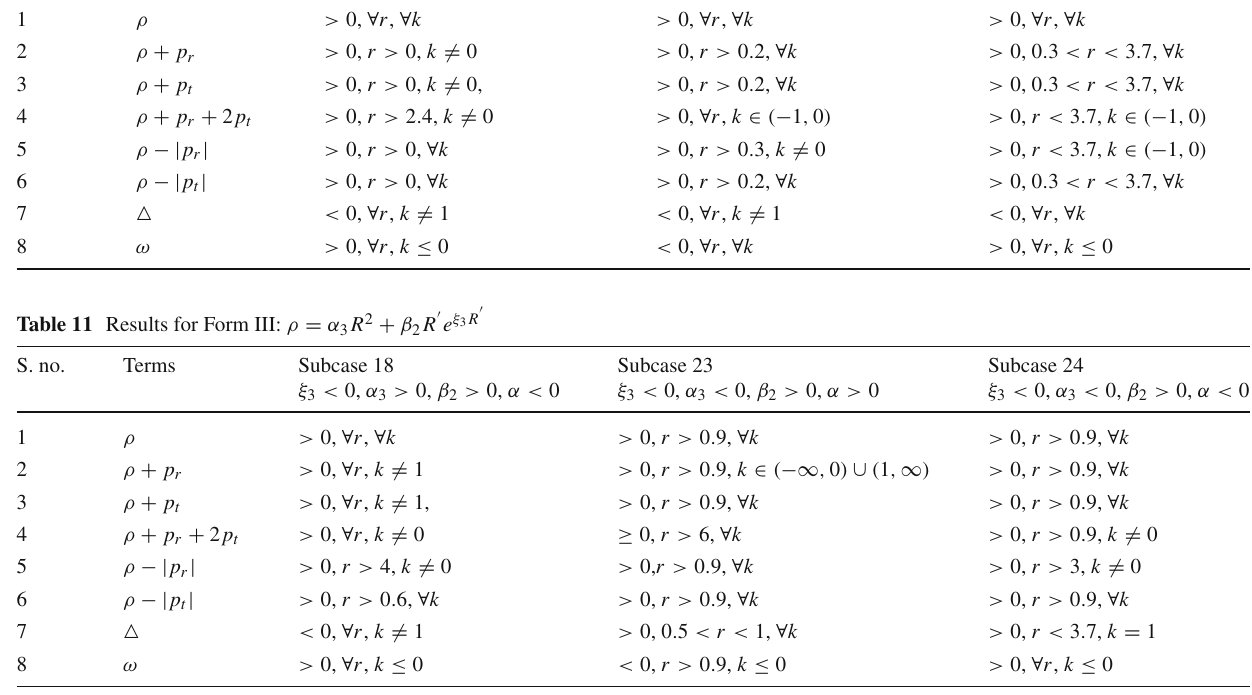
Table 10 Results for Form III: ρ = α 3 R 2 + β 2 R (cid:2) e ξ 3 R S. no.